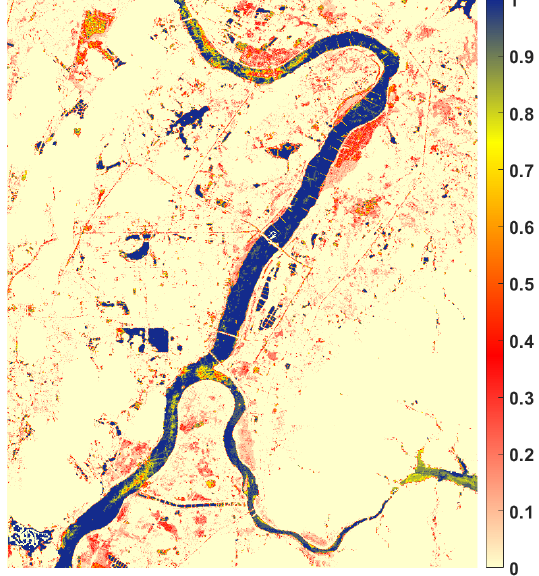
Figure 6 Frequency map of water bodies of Yingde.